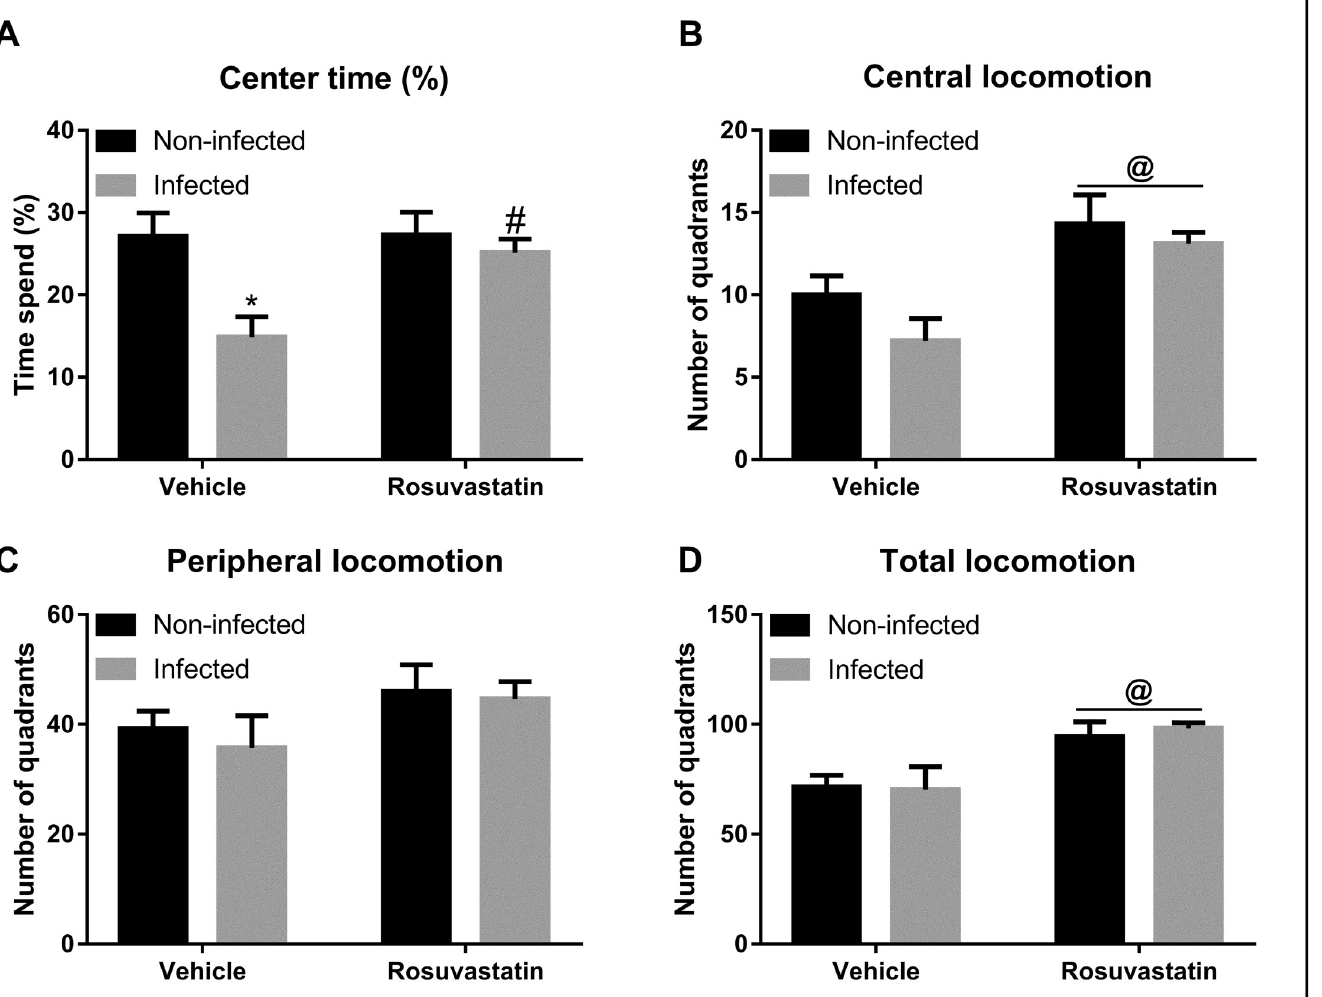
Fig 1. Behavioral analysis in the Open Field (OF) test in animals non-infected and infected with Toxoplasma gondii ME-49 strain and treated with rosuvastatin or vehicle. The bars represent the mean ± SEM. � P < 0.05 vs respective non-infected group, # P < 0.05 vs respective vehicle group, @ P < 0.05 indicating main effect of treatment. Two-way ANOVA followed by Bonferroni post-hoc test (n = 10/group).